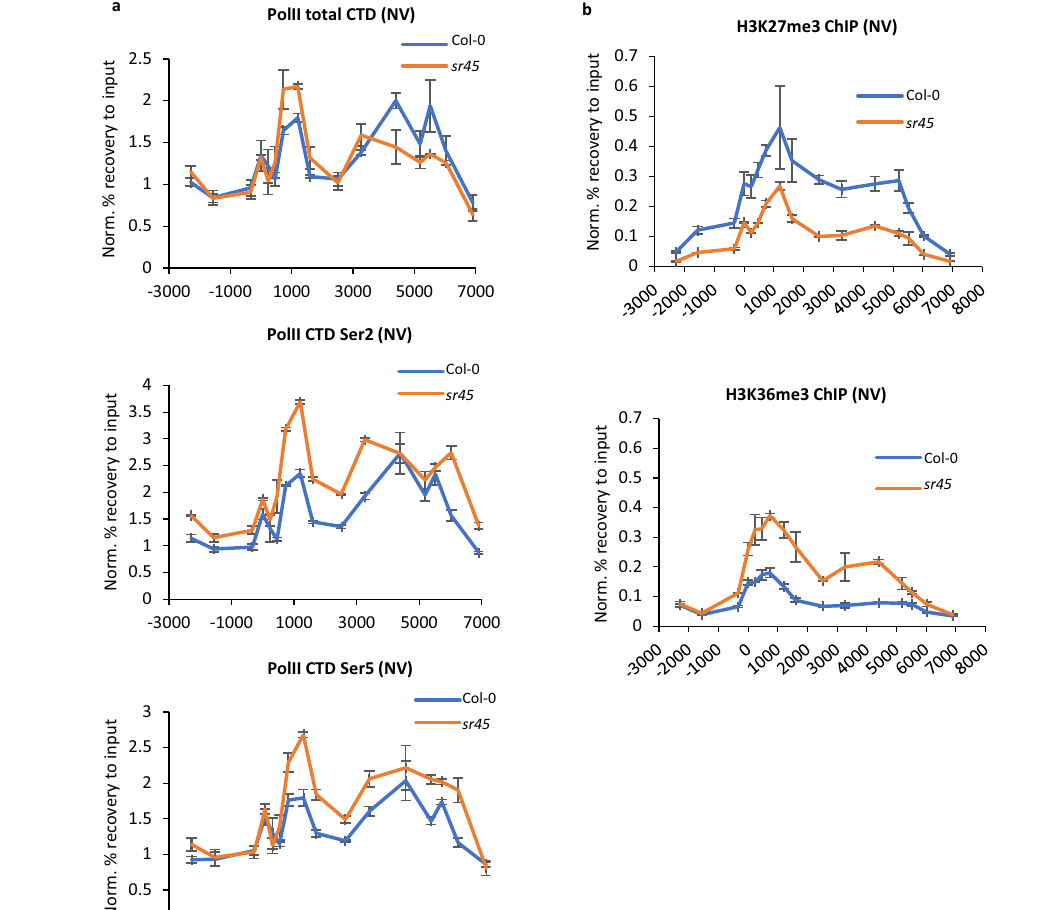
Fig. 3 | SR45 in fl uences the pro fi le of RNA PolII and histone modi fi cations at FLC . a RNA Polymerase II (PolII) ChIP enrichment. X-axis depicts the midpoint position of the amplicon at the FLC locus, amplicon 0=transcriptional start site (TSS). Y-axis corresponds to % recovery to input values normalized to the house- keepinggene ACT7 .NVnon-vernalized; N =3biologicalreplicates;errorbars=SEM.